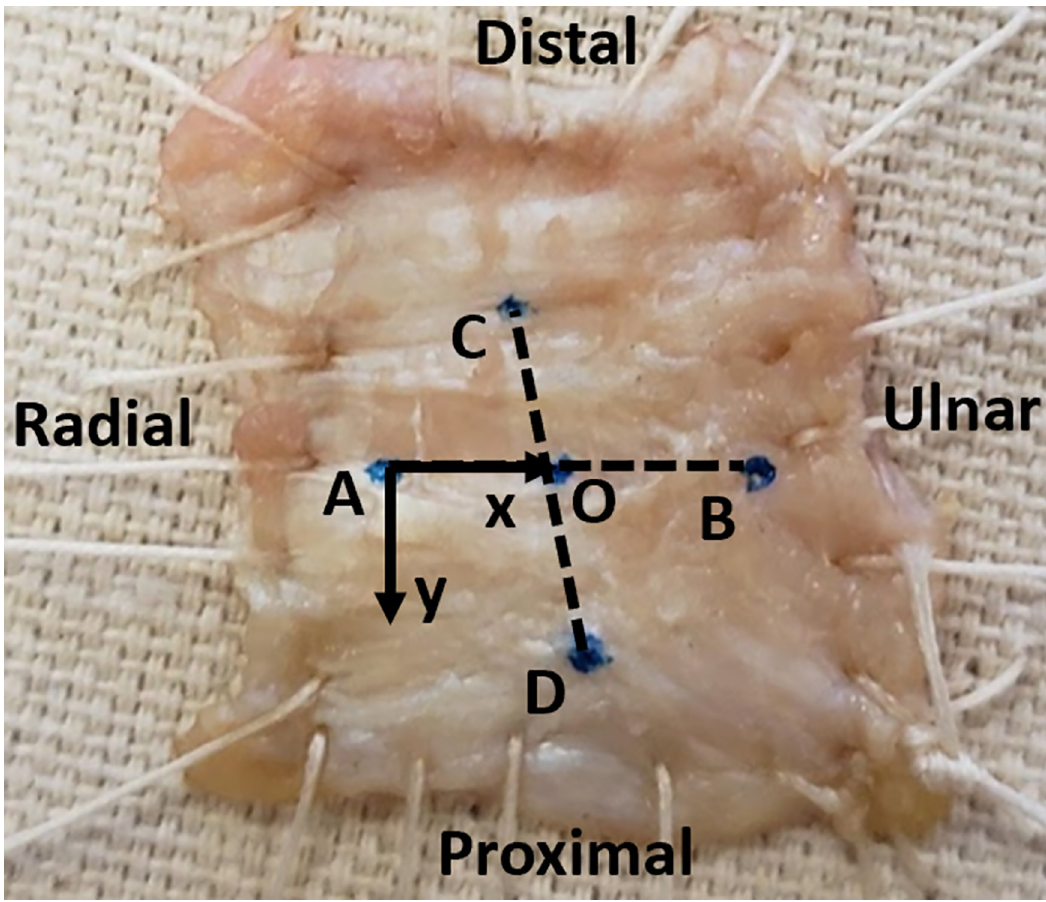
Fig 1. TCL sample preparation. A TCL specimen and a coordinate system associated with the injection point A. Coordinate systems at O, B, C, D are similarly established with x-, y-, z-axes identical, but the origin shifted to these